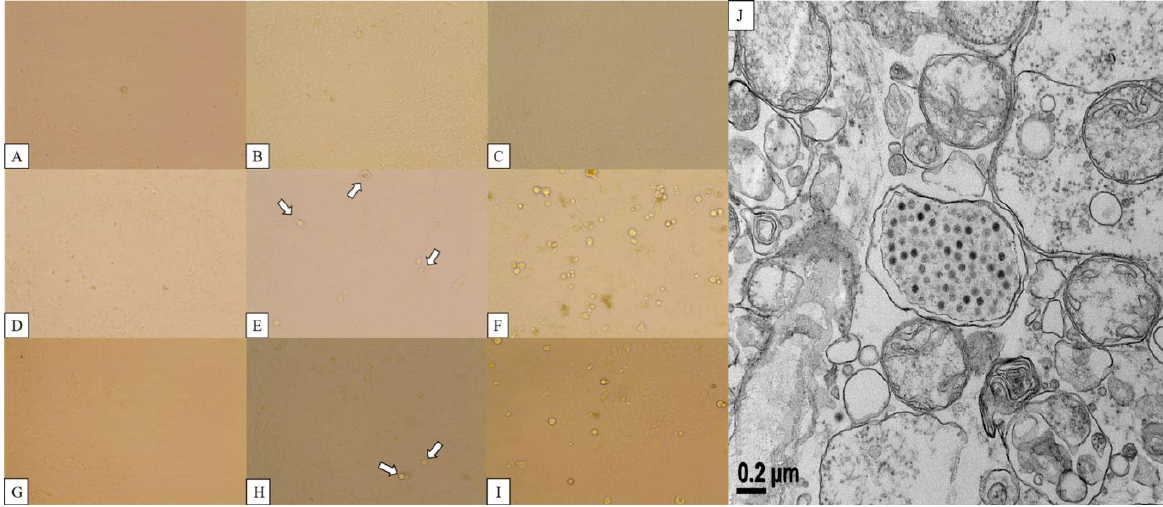
Figure 1. ( A )–( C ) Normal Vero cell; ( D )–( F ) CPE after inoculation of CAdV-2/18Ra-54; ( G )–( I )